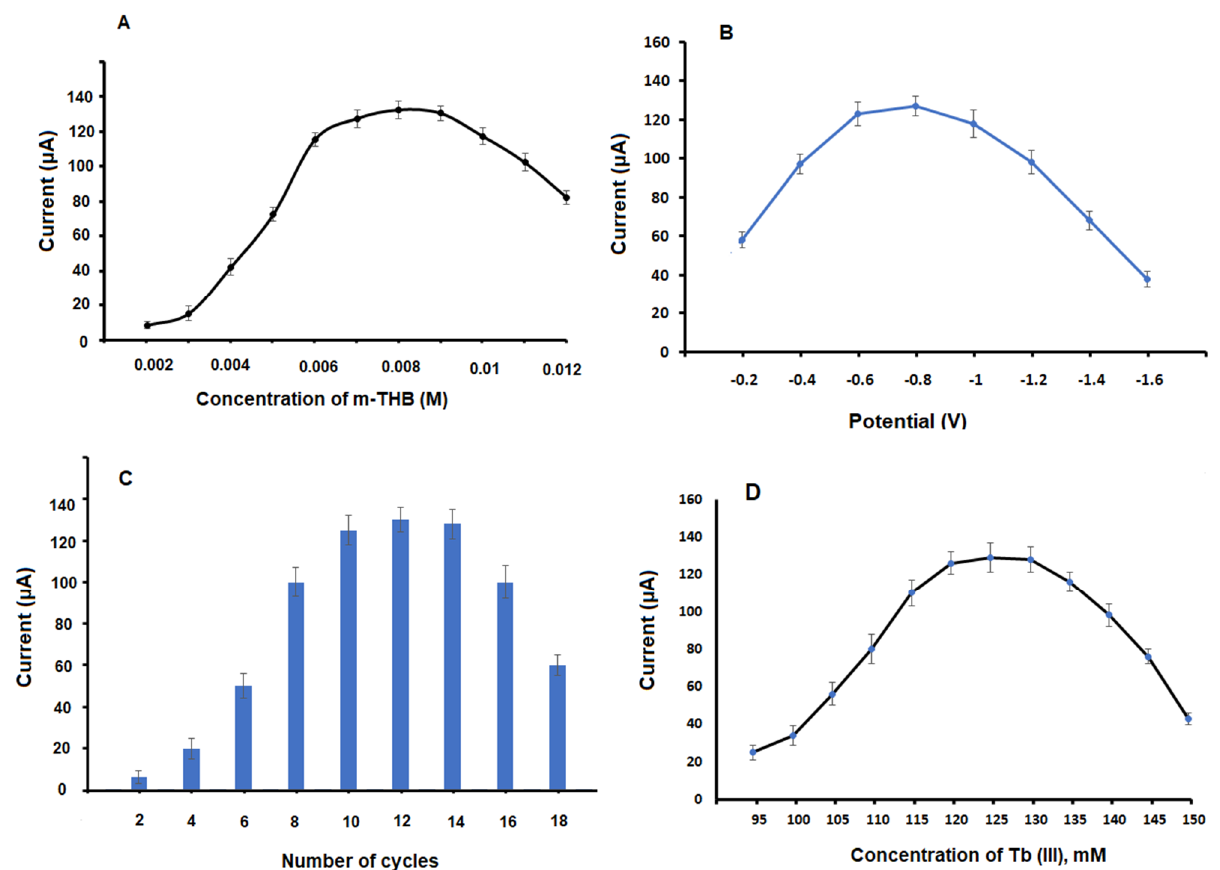
Figure 1. The effects of: ( A ) concentration of m-THB, ( B ) potential used in the polymerization of m-THB, ( C ) number of cycles for polymerization of m-THB and ( D ) concentration of Tb (III) on the current value of FAV (70 × 10 −9 M) using Tb NPS @ poly m-THB/PGE.